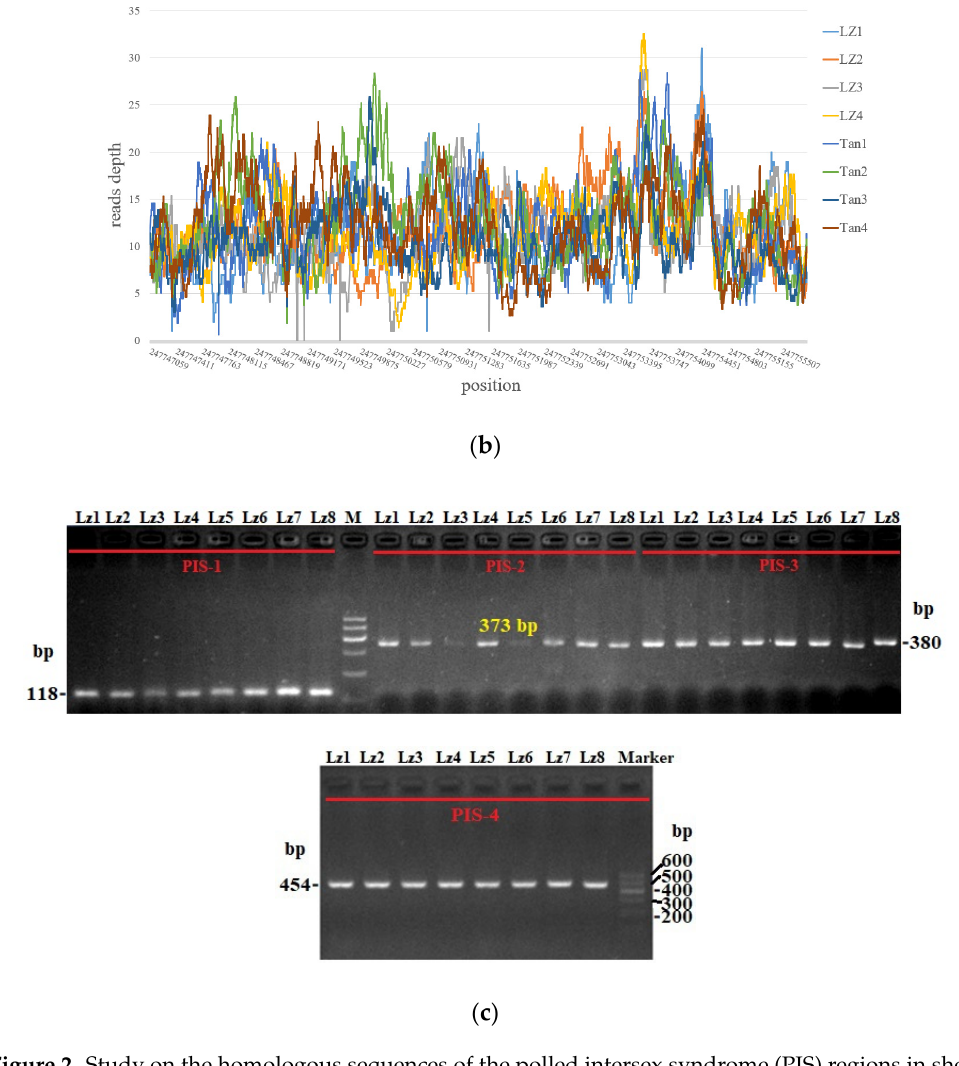
Figure 2. Study on the homologous sequences of the polled intersex syndrome (PIS) regions in sheep and goats. ( a ) The comparison results between the sheep chromosome 1: 247747059–250146105 and goat PIS area (the color line represents the matching relationship: goat 8773 bp matched sheep 8787 bp, and goat 2987 kb matched sheep 1813.4 kb). ( b ) The statistics of the read depth in the sheep 8787 bp candidate area. ( c ) Electrophoresis results of the four pairs of primer amplification products, indicating that the four regions of intersex sheep were not missing.